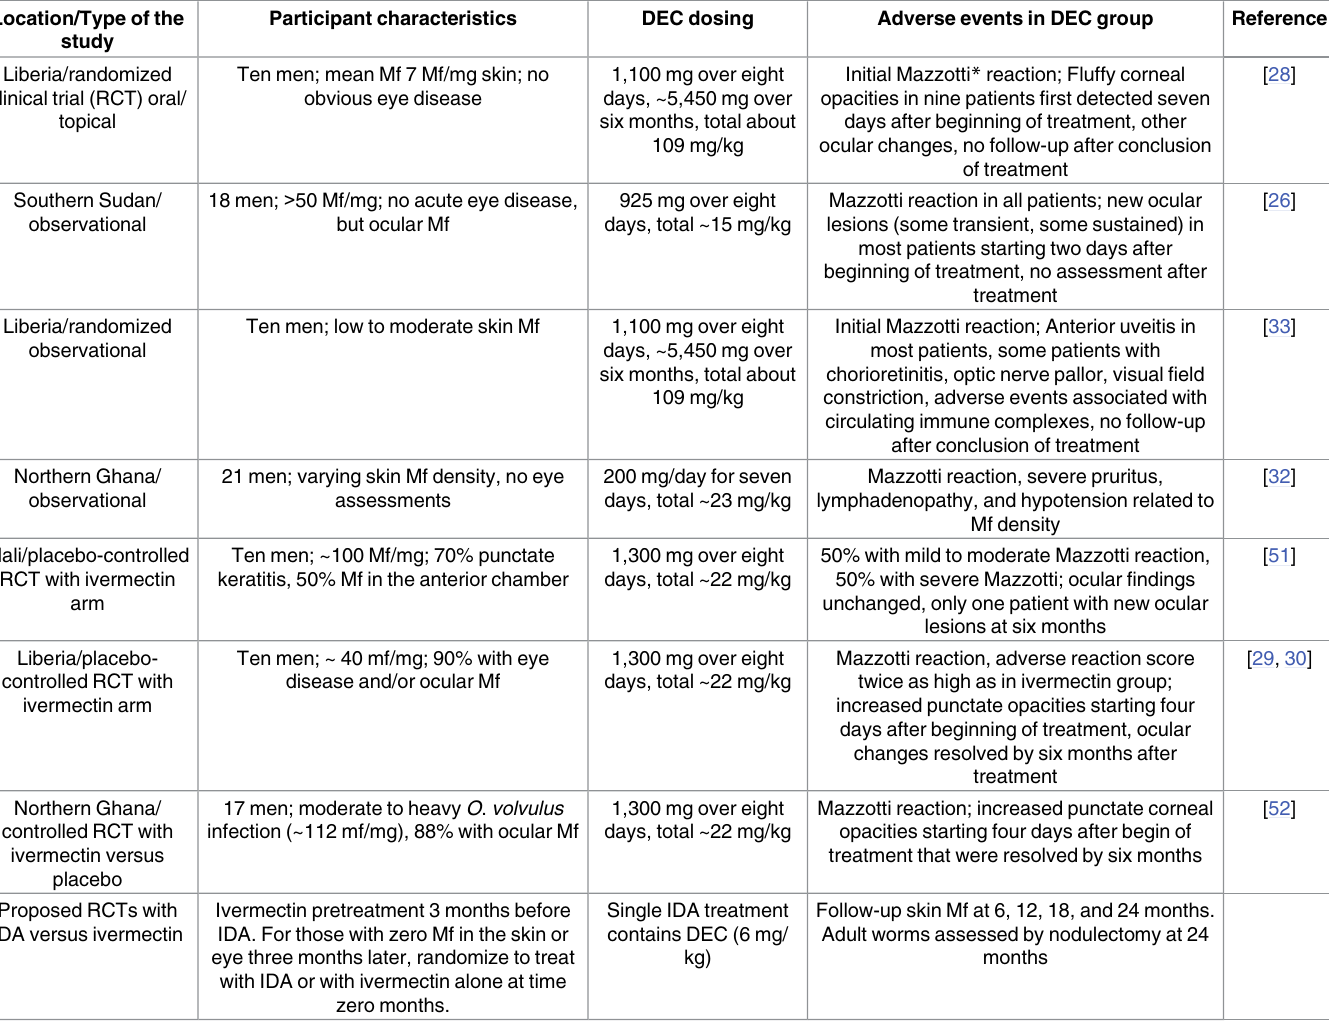
Table 1. Selected studies that report adverseevents of onchocerciasis patients after treatment with DEC compared with a potential study design of IDA. Location/Type of the